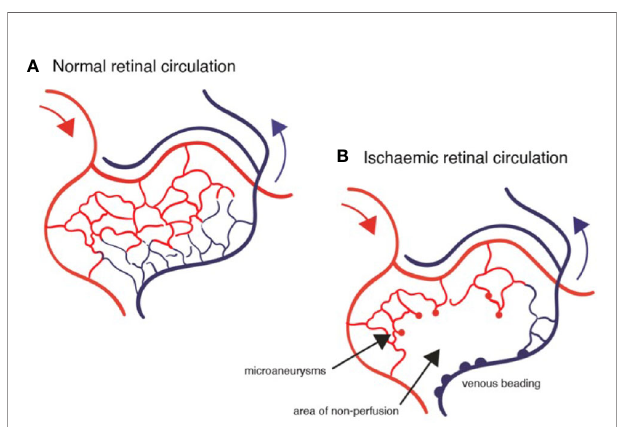
FIGURE 7 | Diagrams of retinal circulation: (A) normal blood fl ow from arterioles (red) through capillary network to venules; (B) abnormal blood fl ow in diabetic retinopathy showing microaneurysms, capillary loss (drop-out), retinal ischemia and venous